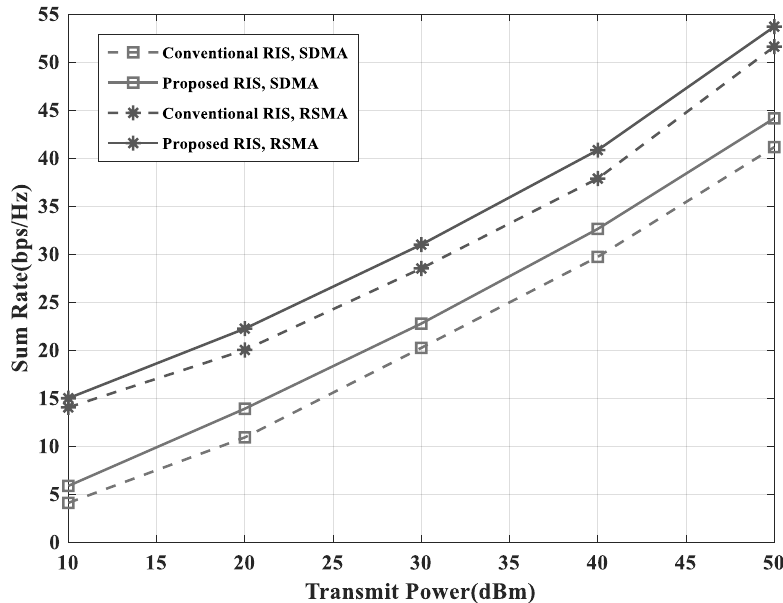
Figure 5. Sum-rate versus transmit power with N G = 4 and N I = 16.